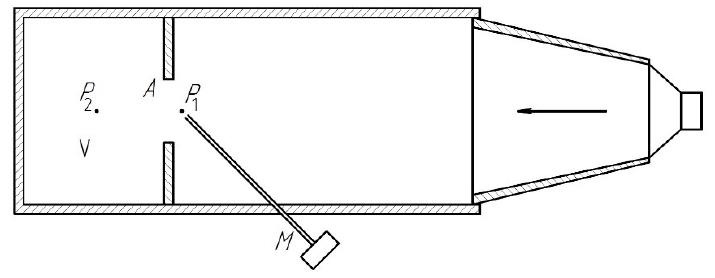
Figure 1. Scheme of the installation for measuring the orifice impedance.